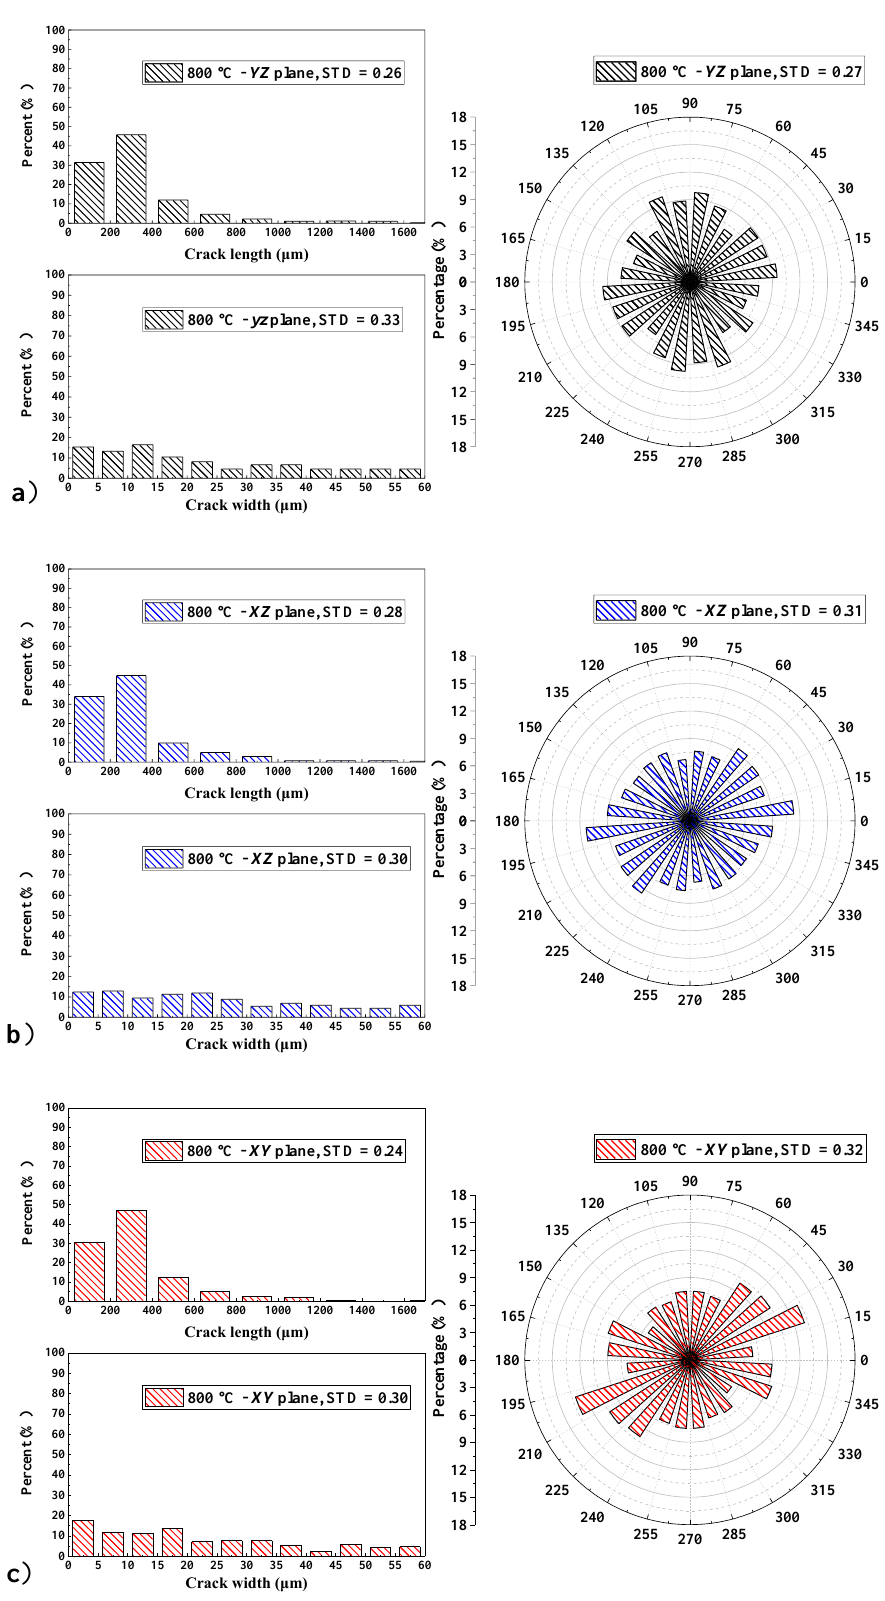
Figure 12. Characteristics of cracks for norite after 800 °C treatment, in ( a ) YZ plane; ( b ) XZ plane; and ( c ) XY plane.